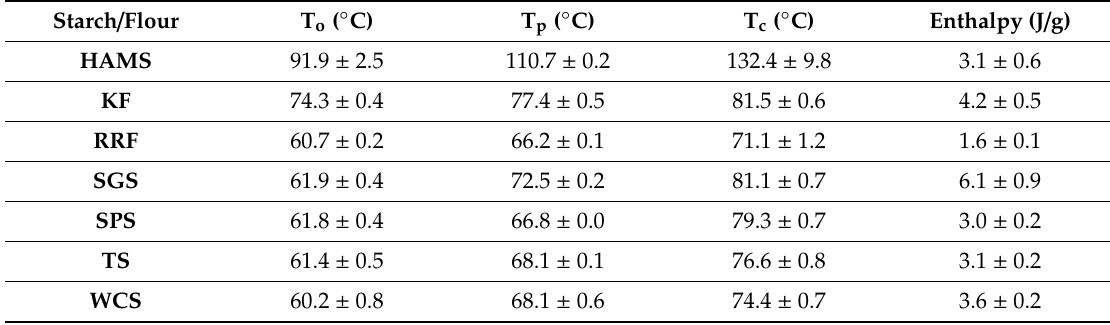
Table 5. The thermal properties of the starch and flours (data are means ± standard